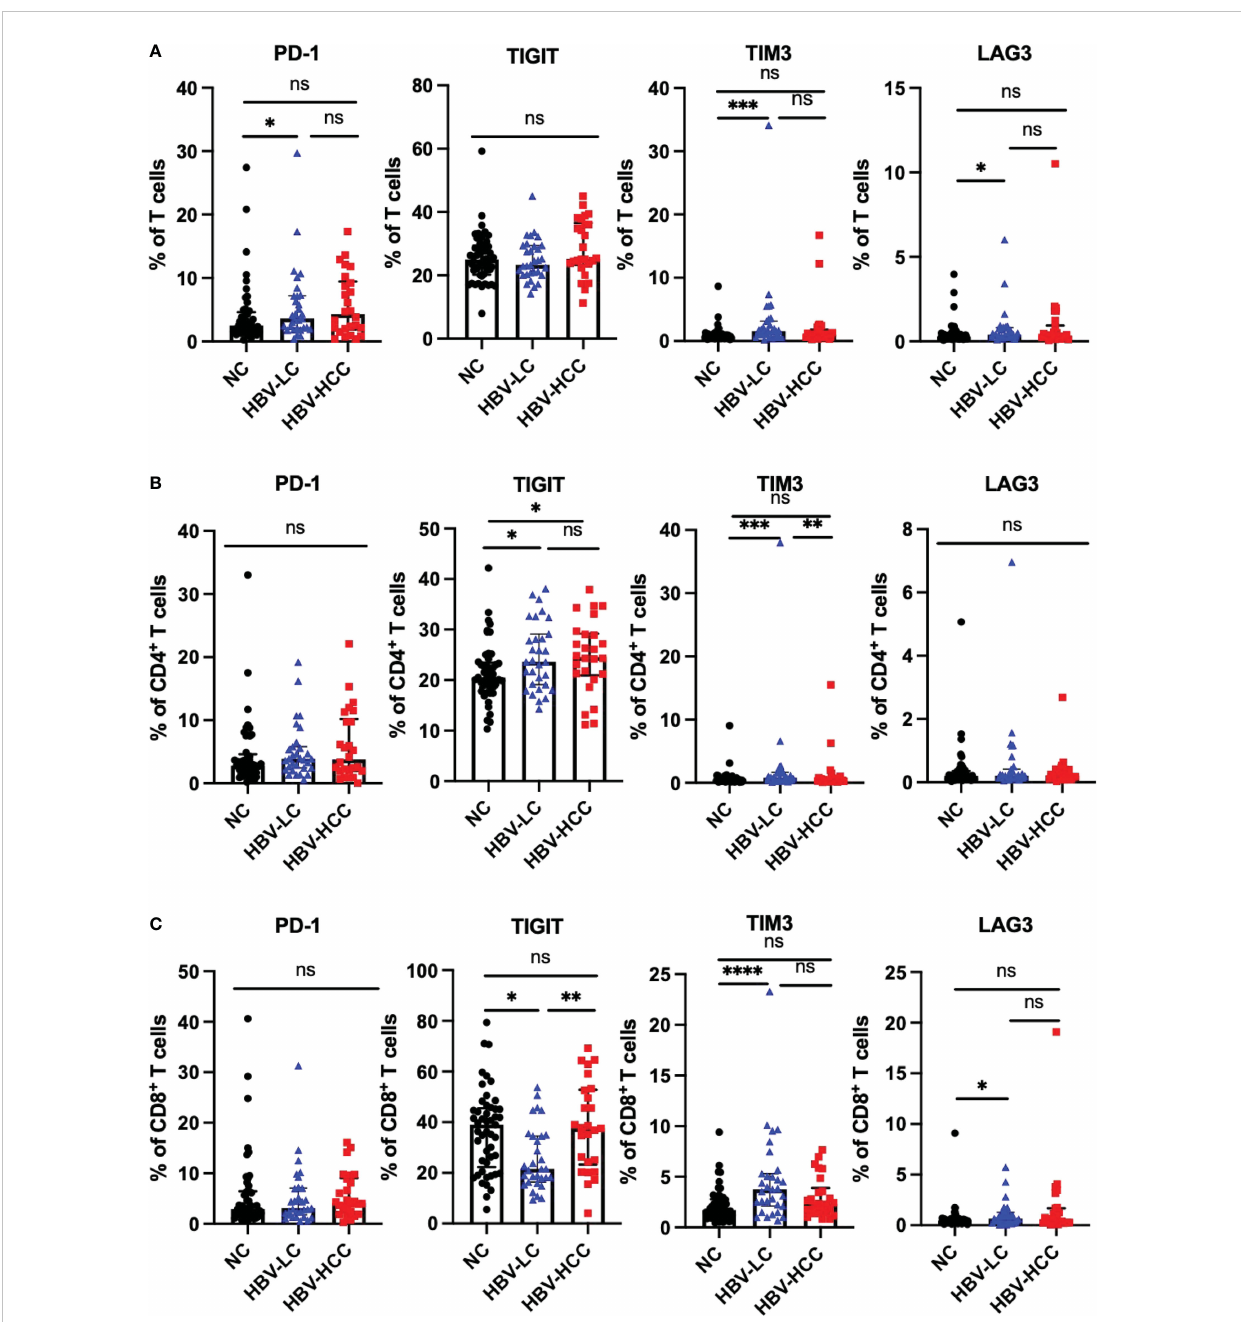
FIGURE 3 Expression of inhibitory receptors on ab T cells. (A) Expression of PD-1, TIGIT, TIM3 and LAG3 on CD3 + T cells. (B) Expression of PD-1, TIGIT, TIM3 and LAG3 on CD4 + T cells. (C) Expression of PD-1, TIGIT, TIM3 and LAG3 on CD8 + T cells. * p <0.05, ** p <0.01, *** p <0.001, **** p <0.0001. ns, not signi fi